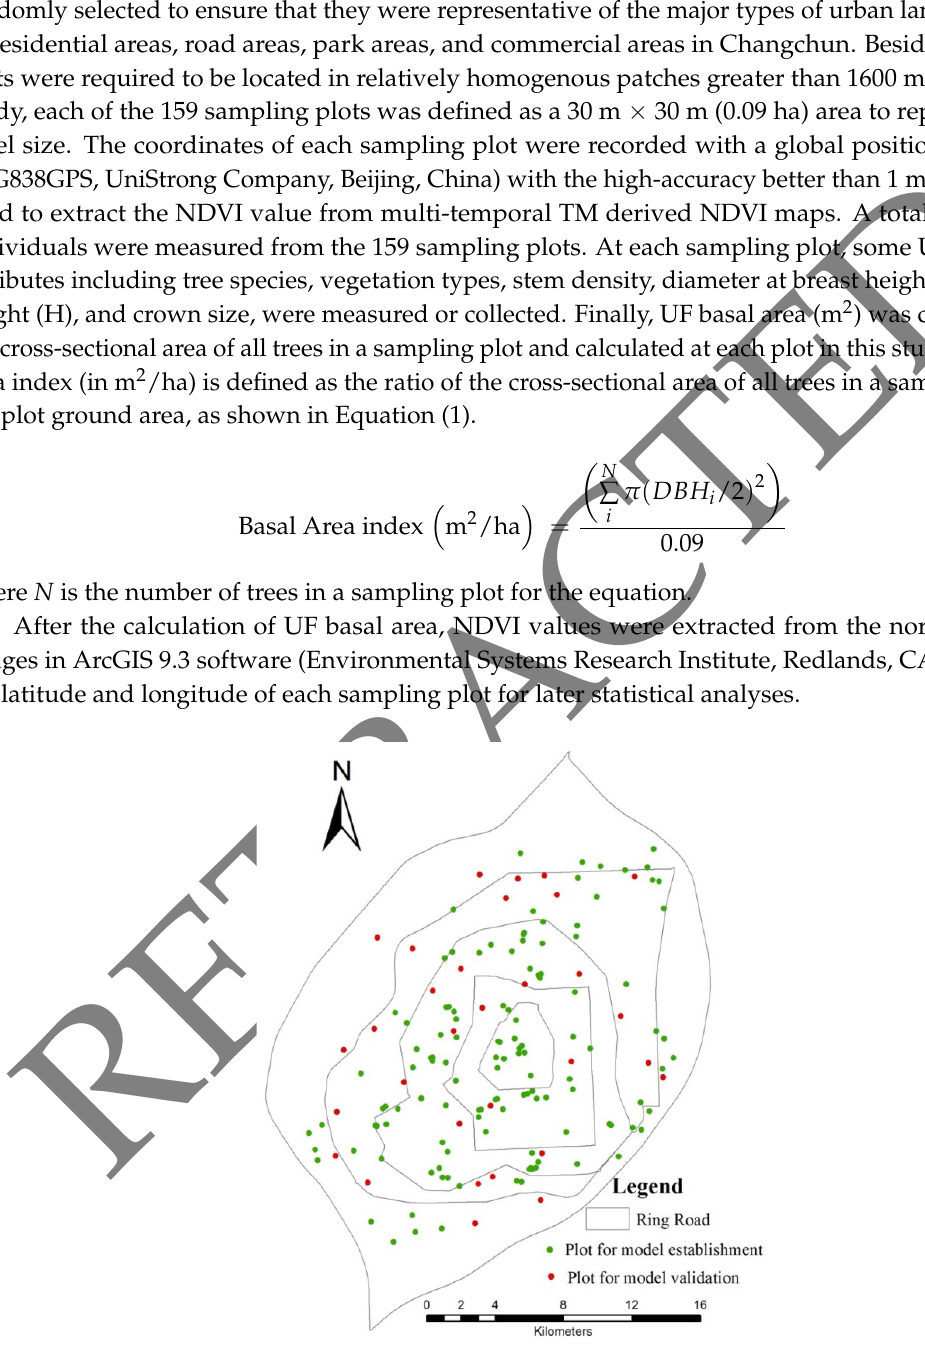
Figure 3. Map of 159 sampling plots in the City of Changchun.